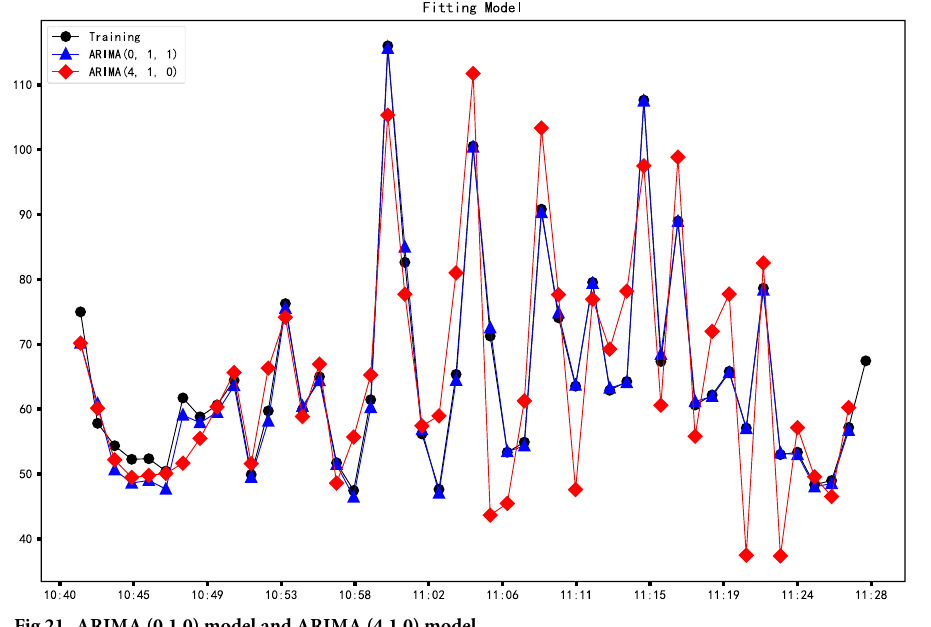
Fig 21. ARIMA (0,1,0) model and ARIMA (4,1,0) model.